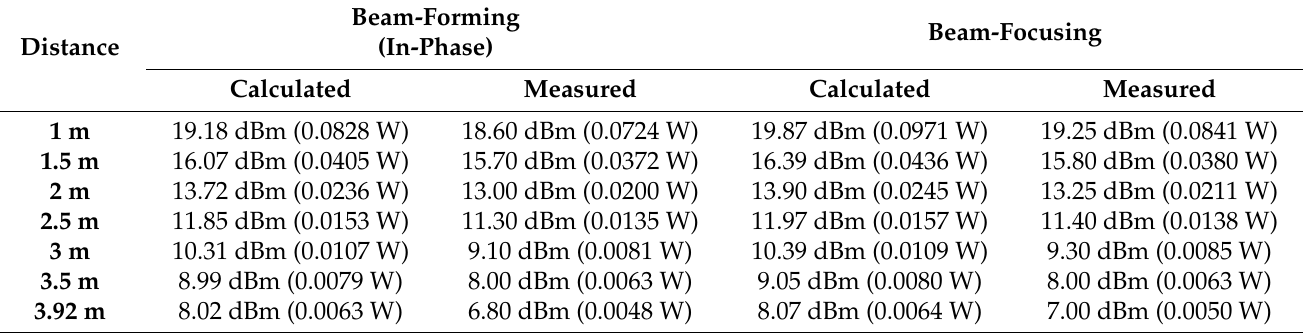
Table 3. Experimental results of 5.73 GHz received power when total transmitted power is 40 dBm (=10 W).